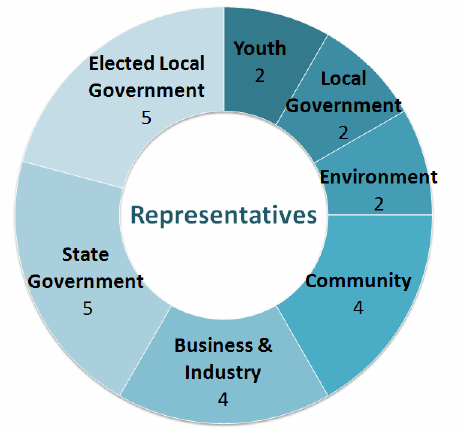
Figure 1 . Stakeholder interests represented on the Gold Coast Waterfuture Strategy Community Advisory